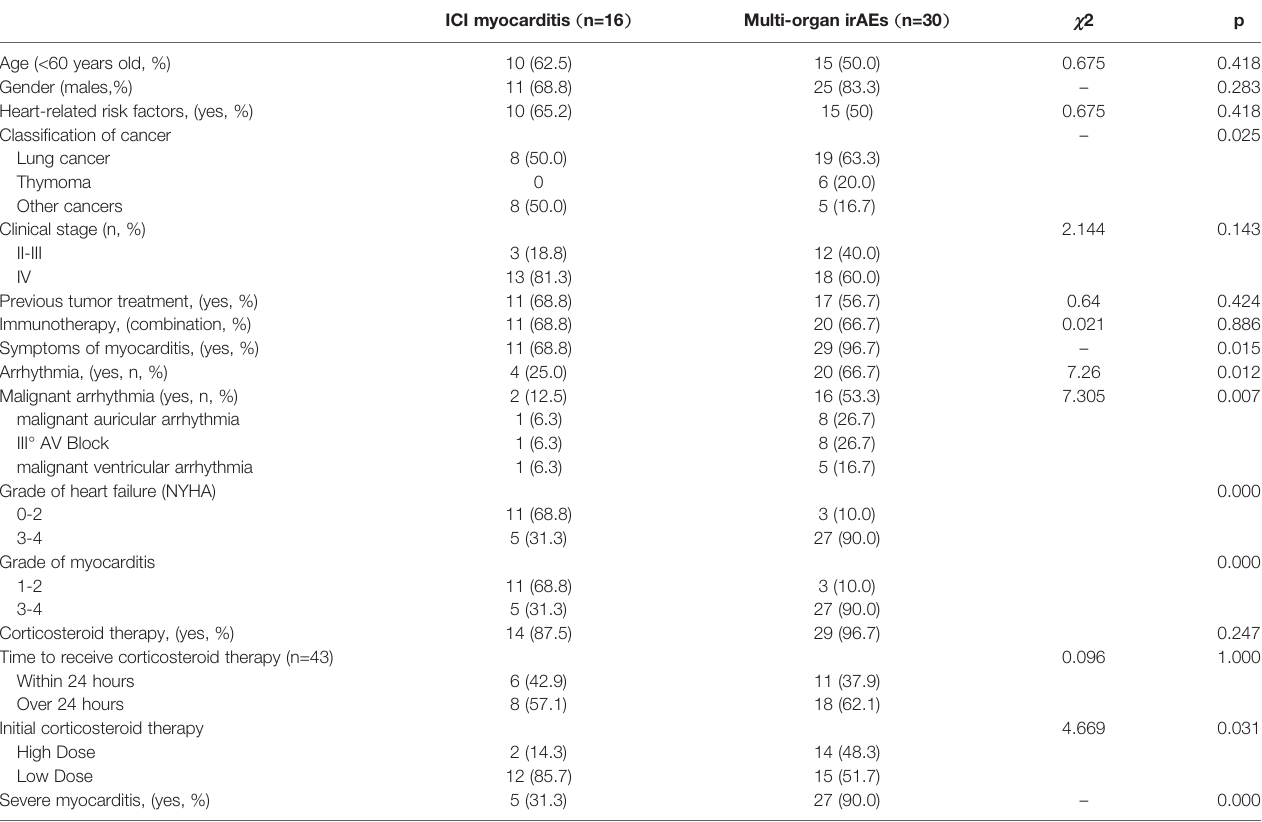
TABLE 3 | Characteristics of the patients with or without other